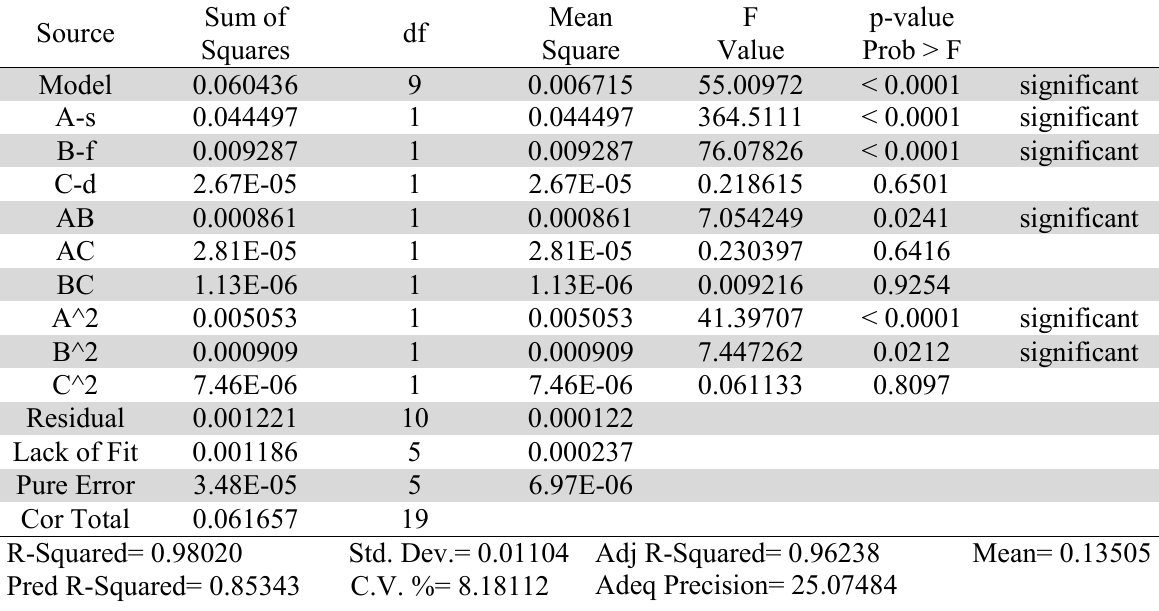
ANOVA results for Al-Si alloy matrix composite (tool wear) Sum of Source